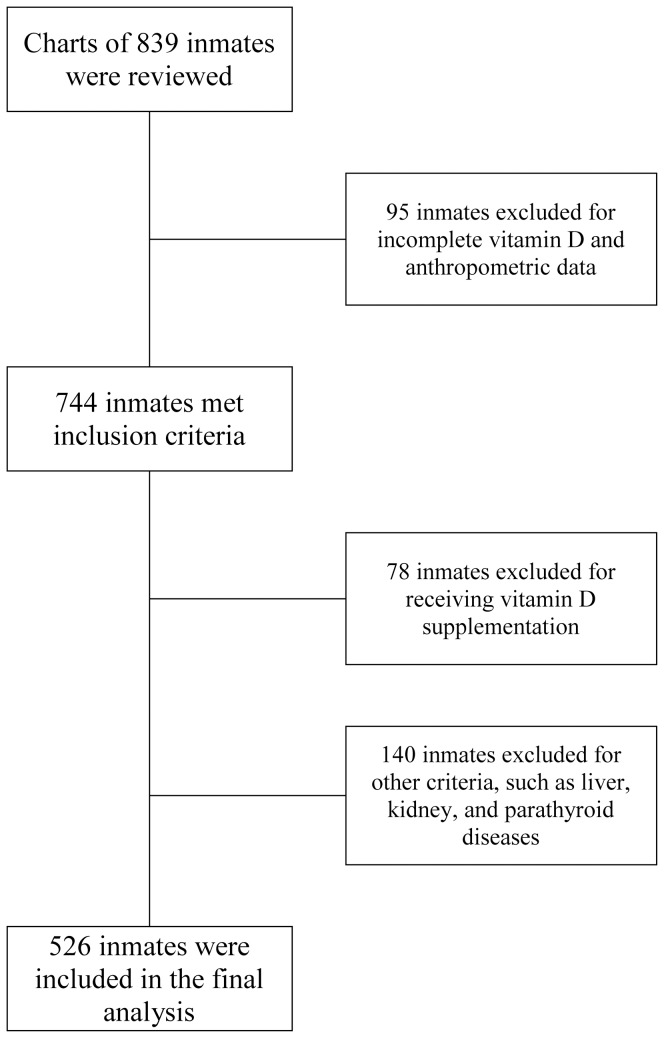
Study Flow Diagram.